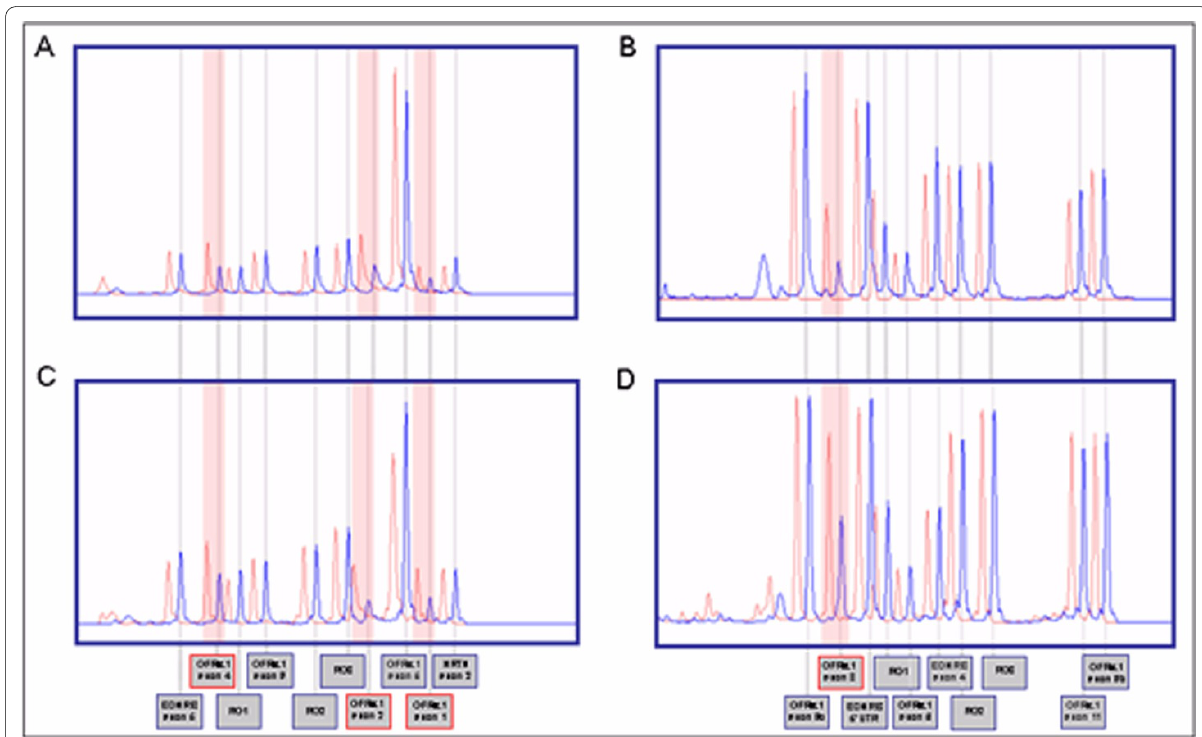
Figure 1 MLPA profiles for control individuals (red) and for the HSCR patient (blue) . Two different probes-mixes are shown (A and C mix 1; B and D mix 2). For those HSCR patients (A and B, HSCR-115; C and D, HSCR-5), it was observed a decrease for the dosage of GFRA1 exons 1, 2, 3 and 4, highlighted in red boxes and by